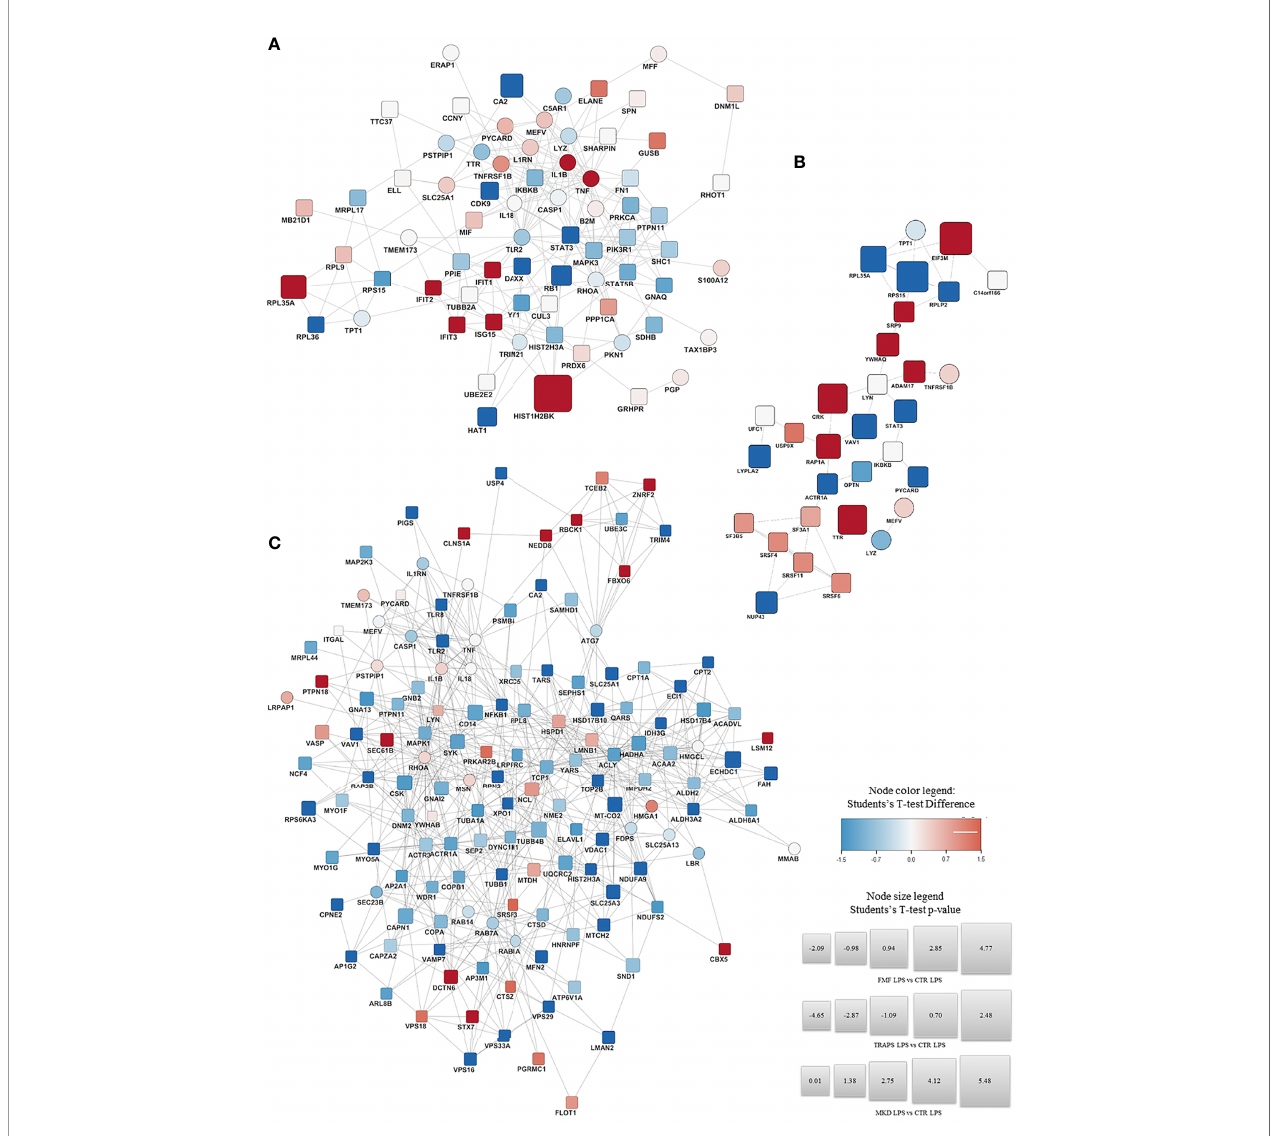
FIGURE 3 | STRING Protein-protein interaction analyses. STRING PPI network connectivity on differential expressed proteins of the different Hereditary Recurrent Fevers integrated with DISEASE annotation of FMF, MVK, and TRAPS. Interaction network of proteins signi fi cantly up- (red) or down- regulated (blue) in LPS-treated monocytes of FMF (A) , TRAPS (B) , and MKD (C) patients compared with HD. Circle: proteins already known to be related to the diseases. Square: new proteins not yet related with the disease The size of each node expresses the percentage of protein